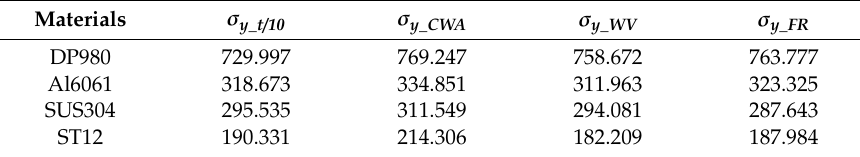
Table 5. Yield strength predicted by di ff erent identification